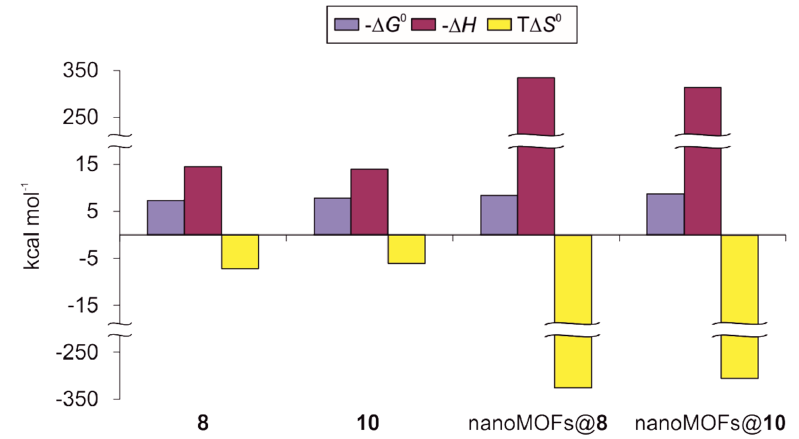
Figure 5. Thermodynamic profiles comprising free energy ( −Δ G 0 ), enthalpy ( −Δ H ), and entropy changes ( T Δ S 0 ) for the interaction of conjugates 8 , 10 , nanoMOFs@ 8, and nanoMOFs@ 10 with ConA changes ( T ∆ S 0 ) for the interaction of conjugates 8 , 10 , nanoMOFs@ 8 , and nanoMOFs@ 10 with ConA in in 20 mM phosphate buffer (pH 7.2) at 25 °C for 8 and 10 , and 10 mM TRIS buffer (pH 7.5) at 25 °C for 20 mM phosphate bu ff er (pH 7.2) at 25 ◦ C for 8 and 10 , and 10 mM TRIS bu ff er (pH 7.5) at 25 ◦ C